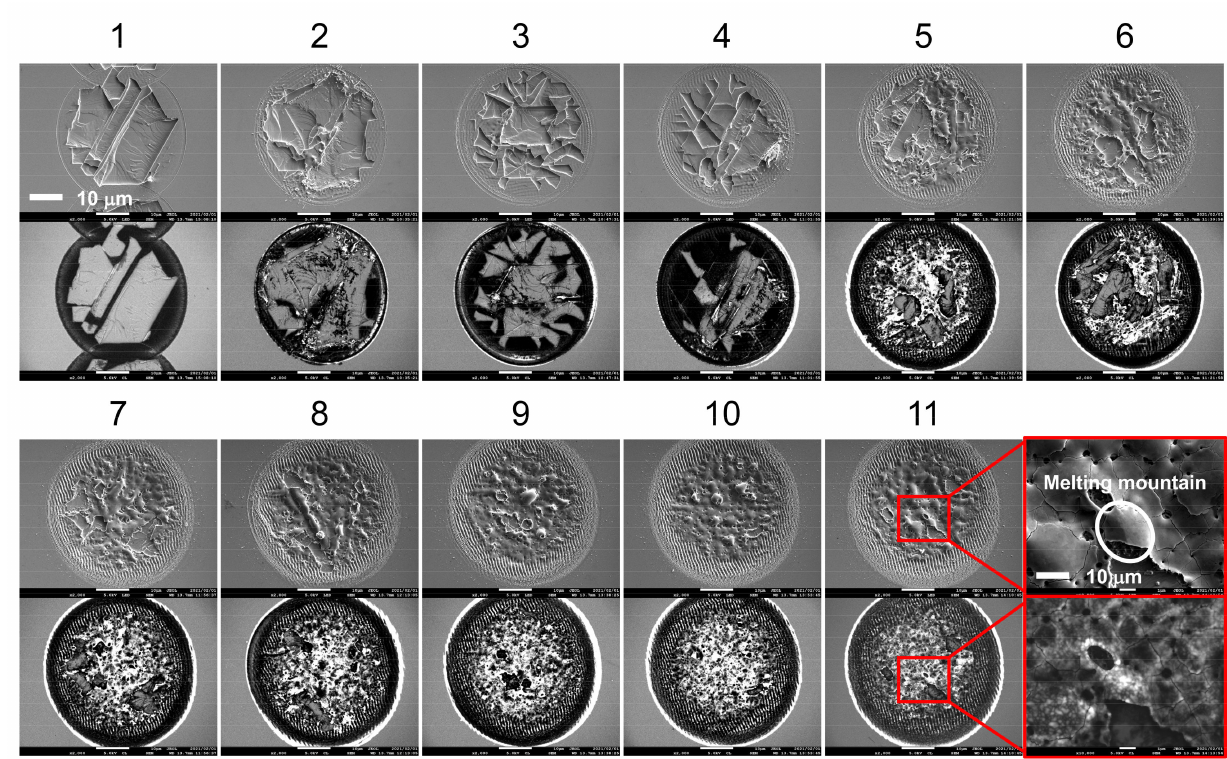
Figure 11. SEM (top) and CL (bottom) images of multi-pulse irradiated samples. The numbers above the SEM images indicate the number of pulses irradiated upon each